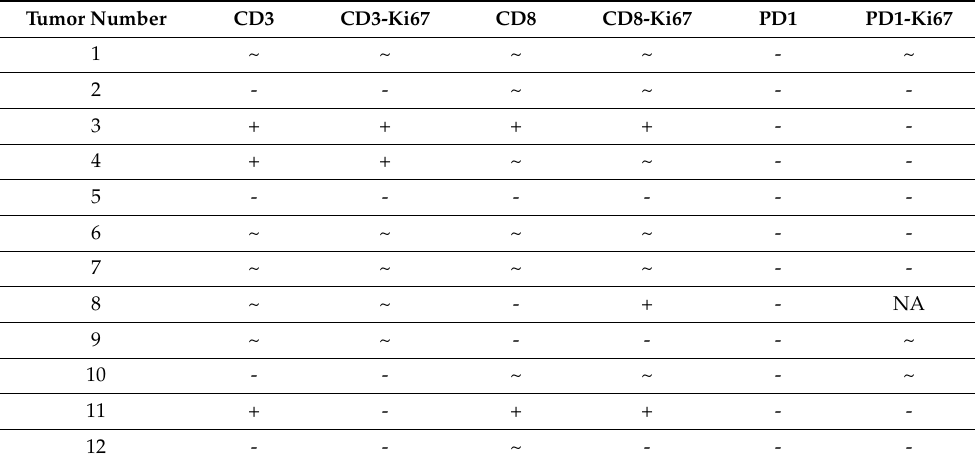
Table 3. Nivolumab-dependent reaction patterns of tumor infiltrating immune cell densities and corresponding proliferation rates.